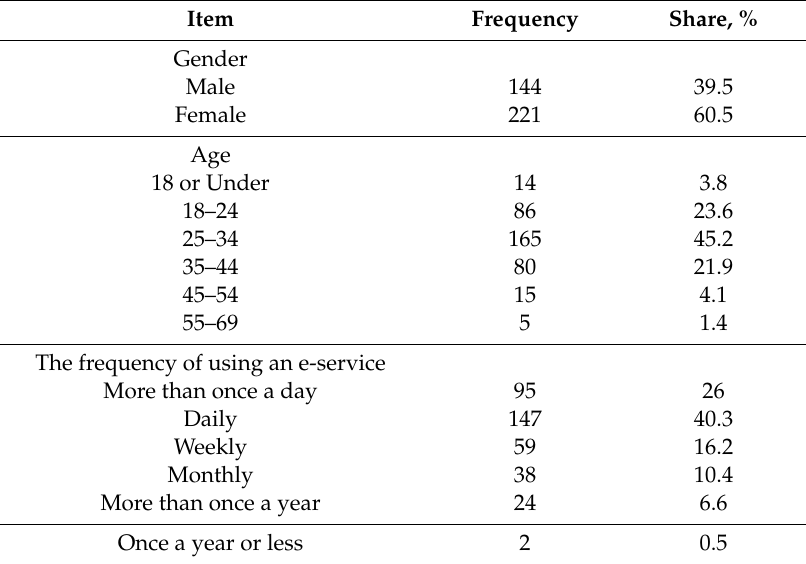
Table 3. Participants’ profile in the final